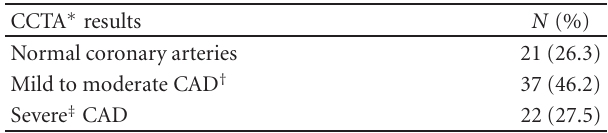
Table 4: Coronary findings of cardiac computed tomographic